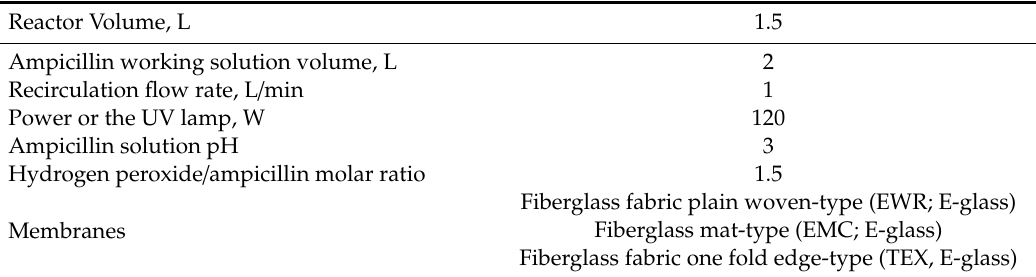
Table 1. Photocatalytic experimental